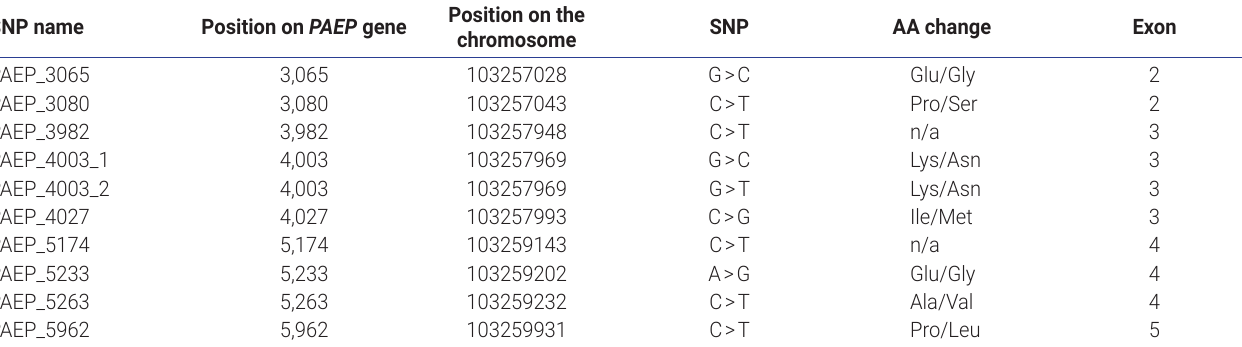
Table 1. Progestogen-associated endometrial protein information (ARS-UCD1.2)